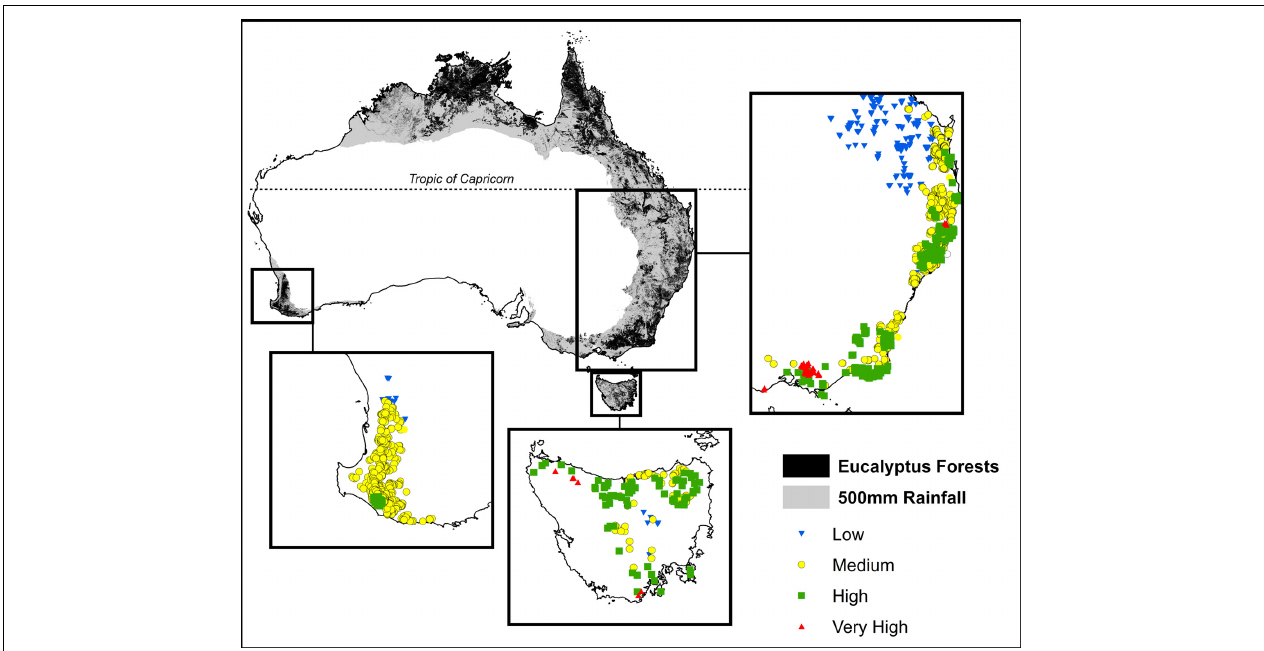
FIGURE 1 | Location of plots showing climatic productivity categories, derived from maximum temperature of the warmest month and the ratio of precipitation to evaporation. These plots were all located outside